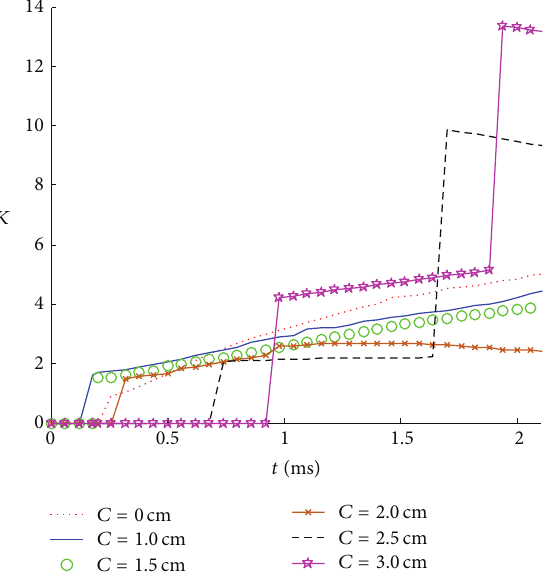
Figure 10: The crevasse radius of different coated shells; Cases 1 – 3 correspond to the no-covering, in-covering, and out-covering.